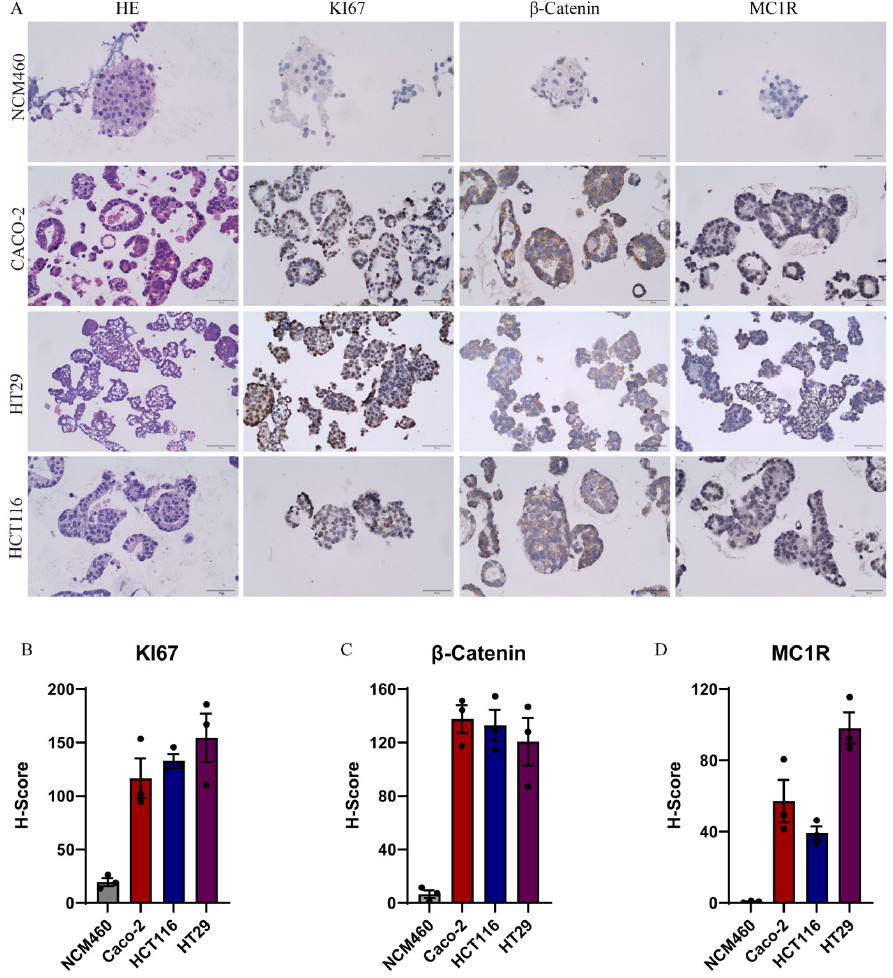
Figure 5. IHC and H-Score analysis of organoids. ( A ) HE, KI67, β -Catenin and MCIR staining results of organoids of NCM460, Caco-2, HCT116, HT29; ( B − D ) H-score analysis of KI67, β -catenin and MCIR of organoids of NCM460, Caco-2, HCT116, HT29. The black dots represent the values of the sample.